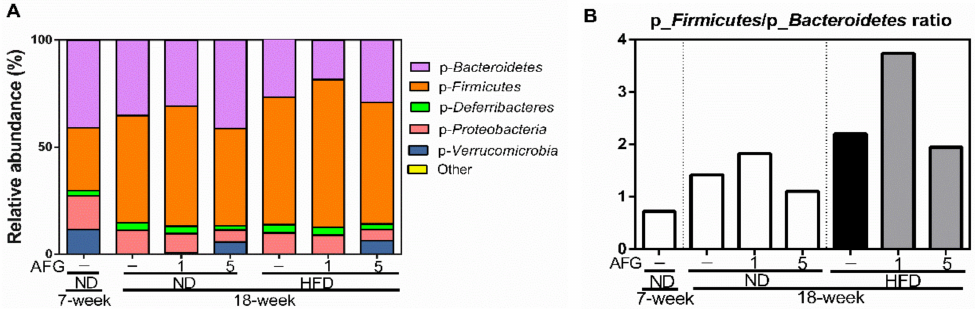
Figure 4. The composition of gut microbiome at phylum level. ( A ) The relative abundance of bacteria at phylum level. ( B ) The ratio of p - Firmicutes to p - Bacteroidetes based on their relative abundance.